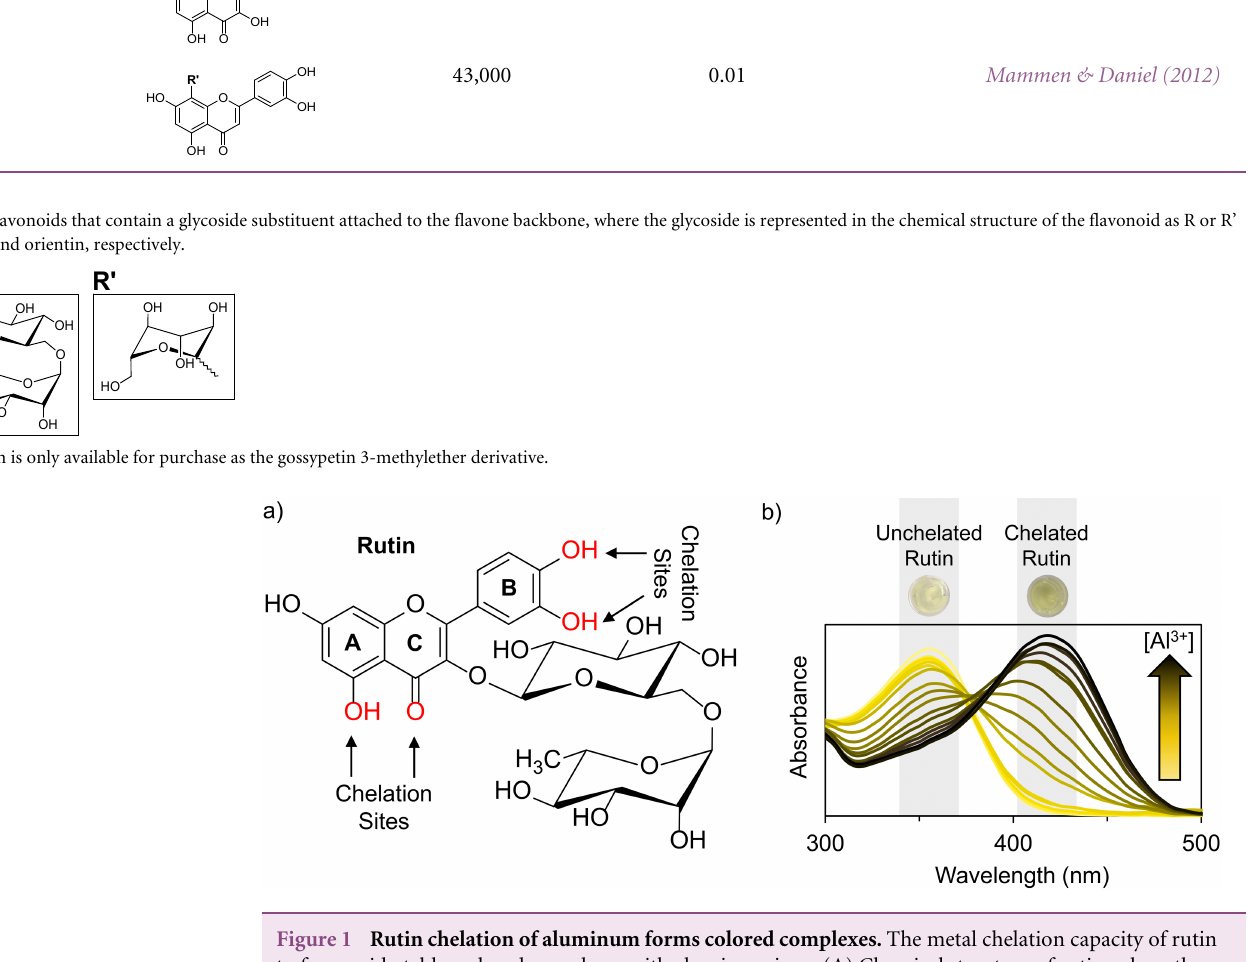
rings of the structure are denoted A–C and possible chelation sites are highlighted in red. (B) Absorbance